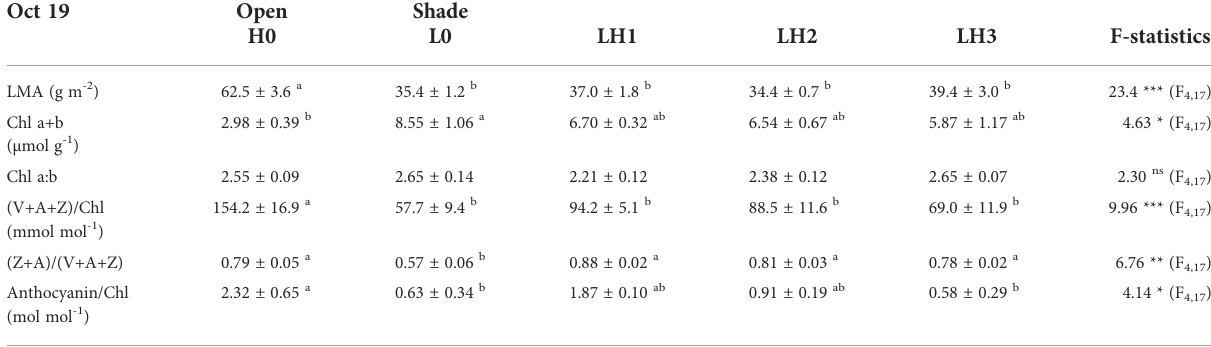
TABLE 5 Leaf mass per area (LMA) and pigments in leaves of fullmoon maple seedlings grown under different light conditions, sampled in the morning of Oct 19.